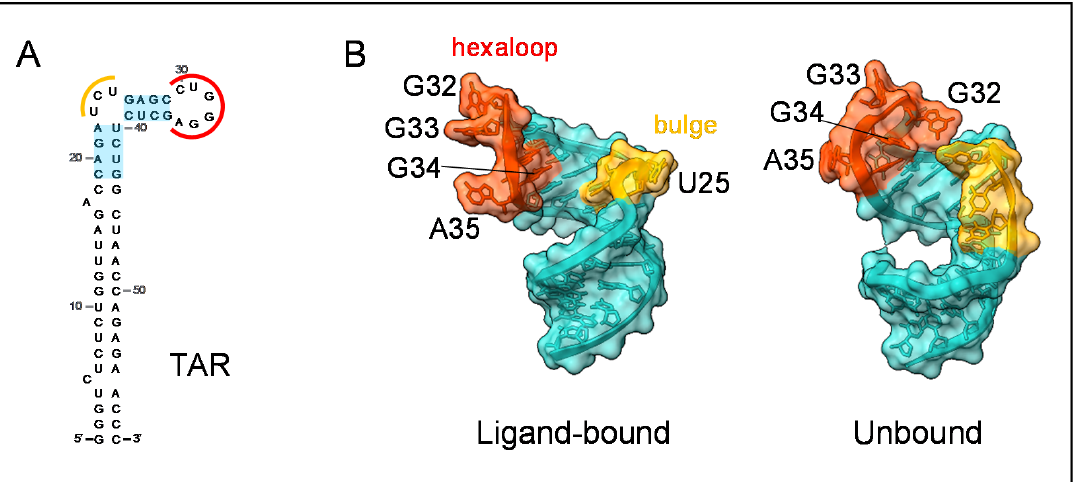
Figure 7. Nucleotide sequence and secondary structure of HIV-1 TAR RNA. ( A ). Highlighted in light blue are the stems present in the solved structures, in yellow the UCU bulge and in orange the G-rich hexaloop. ( B ). Surface representation of ligand-bound state (PDB: 6MCE, TAR bound to the arginine-rich RNA-binding region of Tat) and unbound state of TAR RNA (PDB: 1ANR, model 1). Indicated bases of the G residues of the hexaloop and the flanking UCU bulge are oriented inward, contributing to the bend of the helical axis and the tightening of TAR major groove (adapted from [115]). The direct interaction of HIV-1 IN CTD with TAR has also been assessed